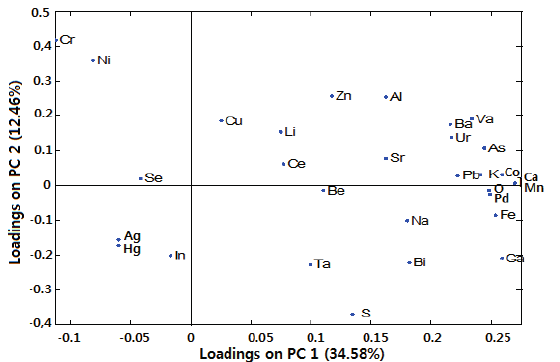
Figure 4 - Loadings representing the influence of different elements on spectroscopic readings of water samples collected at various locations along the Todos os Santos